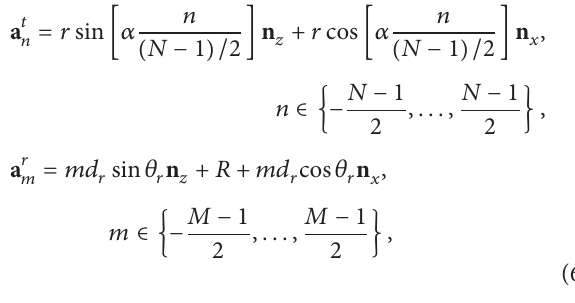
Figure 2: LOS capacity by varying the number of transmitters ( 𝑁 = 𝑀 ), for different values of the deviation factor 𝜂 (dB).